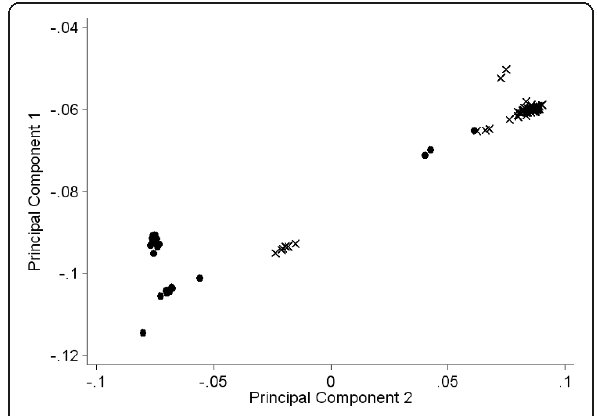
Figure 3 Scatterplot of newborns along the first and second principal components calculated from genome-wide single nucleotide polymorphism data . Maternally-declared Caucasian newborns are represented by circles and African-American newborns by X ’